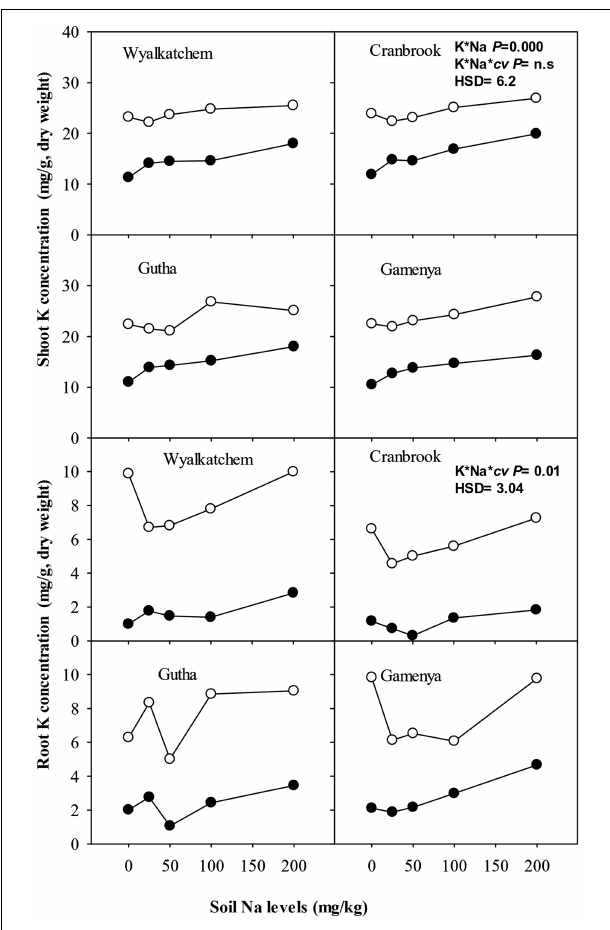
FIGURE 5 | Potassium (K) content (mg/plant) in shoot (upper sub-figures) and root (lower sub-figures; n = 3) of four wheat cultivars, treated with 40 mg K/kg (closed circle) and 100 mg K/kg (open circle), and five soil Na levels (0, 25, 50, 100, and 200 mg Na/kg) for 8 weeks. See Table 2 for analysis of variance